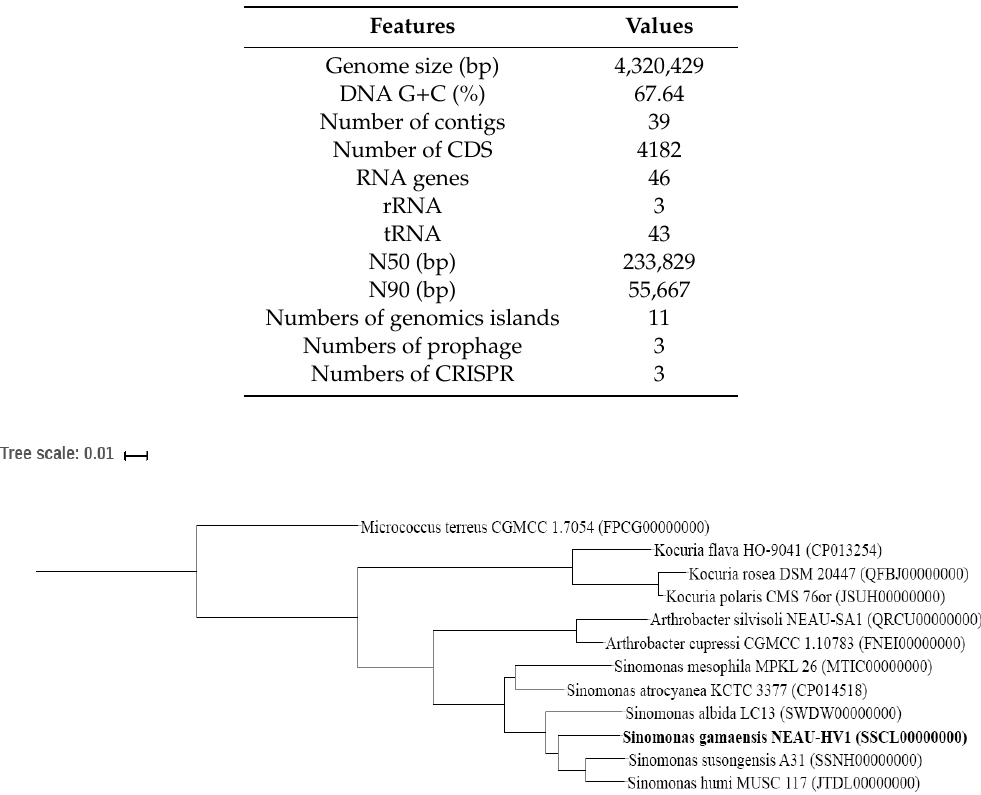
Table 2. General features of the genome of NEAU-HV1 T .